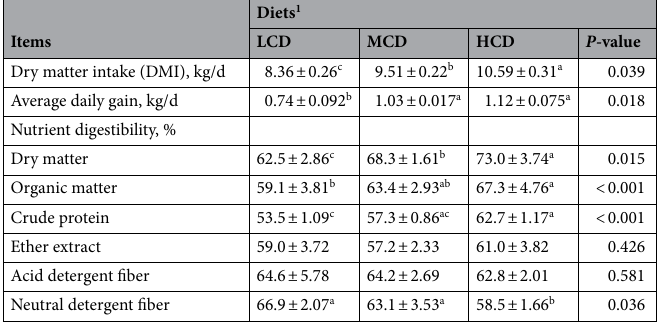
Table 2. Effect of different dietary levels of concentrate on intake, average daily gain and digestibility in Angus cows. a,b,c Means bearing different superscripts in the same row differ significantly ( P < 0.05). 1 LCD, 35:65 concentrate:forage; MCD, 50:50 concentrate:forage; HCD, 65:35 concentrate:forage;